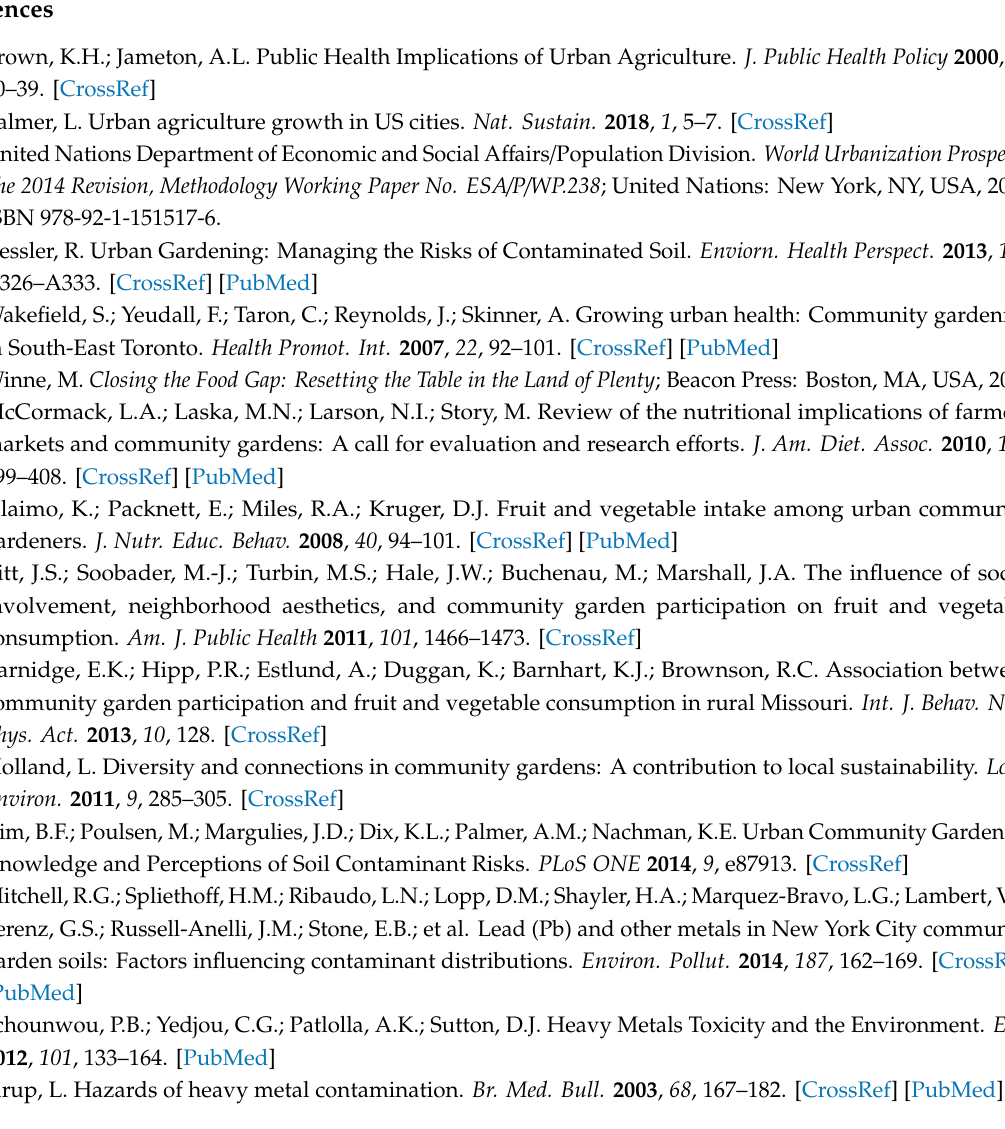
Figure A8. Likelihood of participants taking action to remove heavy metal soil contaminants if made aware of them by racial identity. Total question respondents: 41 .